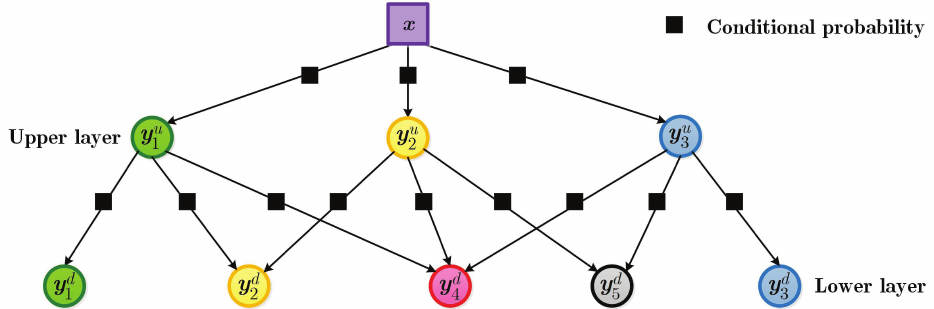
Figure 5. The causal connections between adjacent layers are modeled by the Bayesian network. The input image x is first coarsely classified into labels y u in the upper layer are finely labeled into y d probabilities of the sub-regions in the lower layer, conditioned on their parents’ regions in the upper layer, are denoted by black squares.